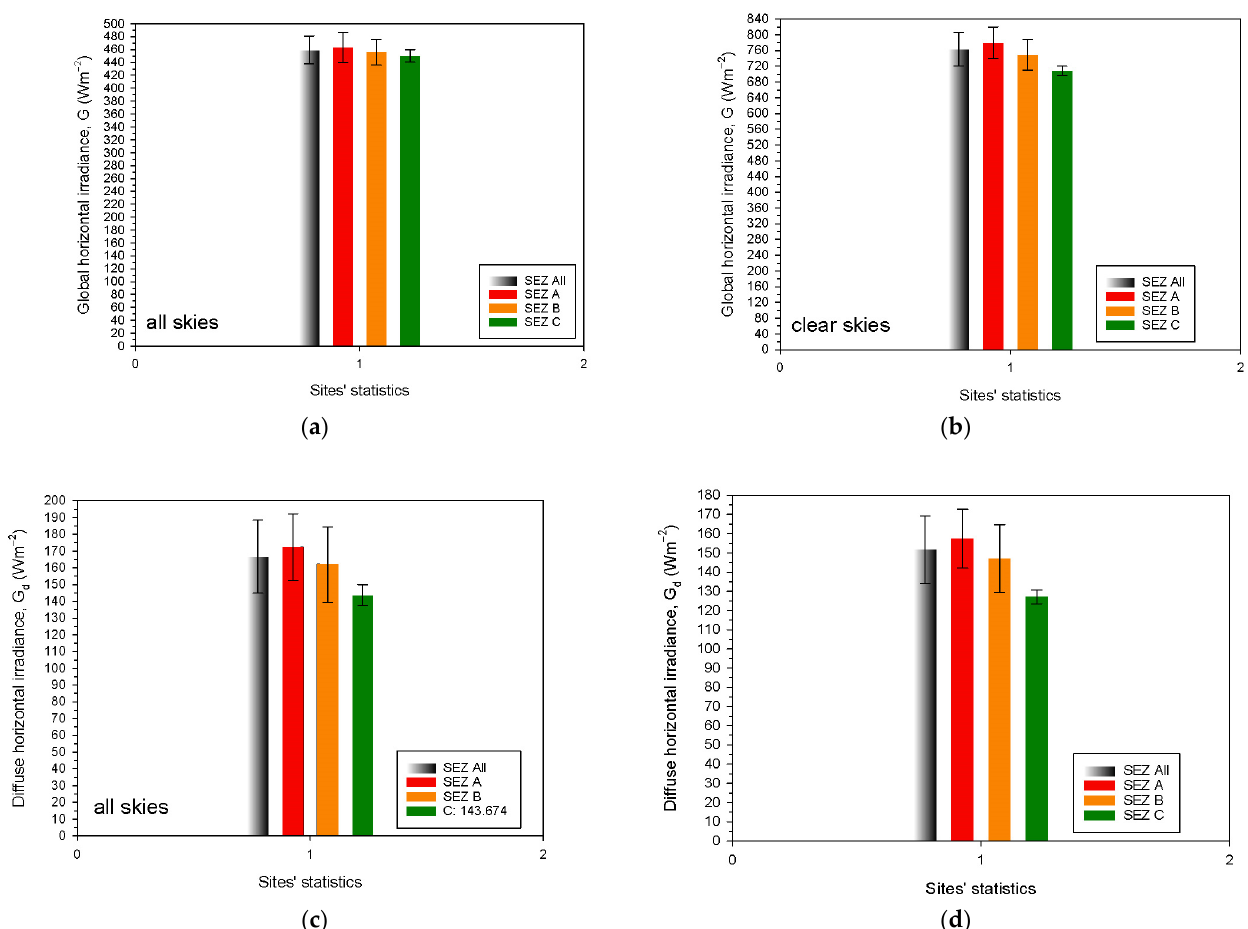
Figure 3. Annual mean ( a ) G and ( c ) G d values for all-sky conditions, and annual mean ( b ) G and ( d ) G d values for clear-sky conditions over Saudi Arabia in the period 2013–2021. The 3 colored bars indicate the average annual values of the solar components for the corresponding SEZ over all sites to which they belong; the black bar includes all sites irrespective of their SEZ. The error bars represent the ± 1 σ ( ± 1 standard deviations) around the means. The numbers on the x -axis have no real meaning. All plots were derived with the SYSTAT’s SigmaPlot 14.0.0.124 graphing